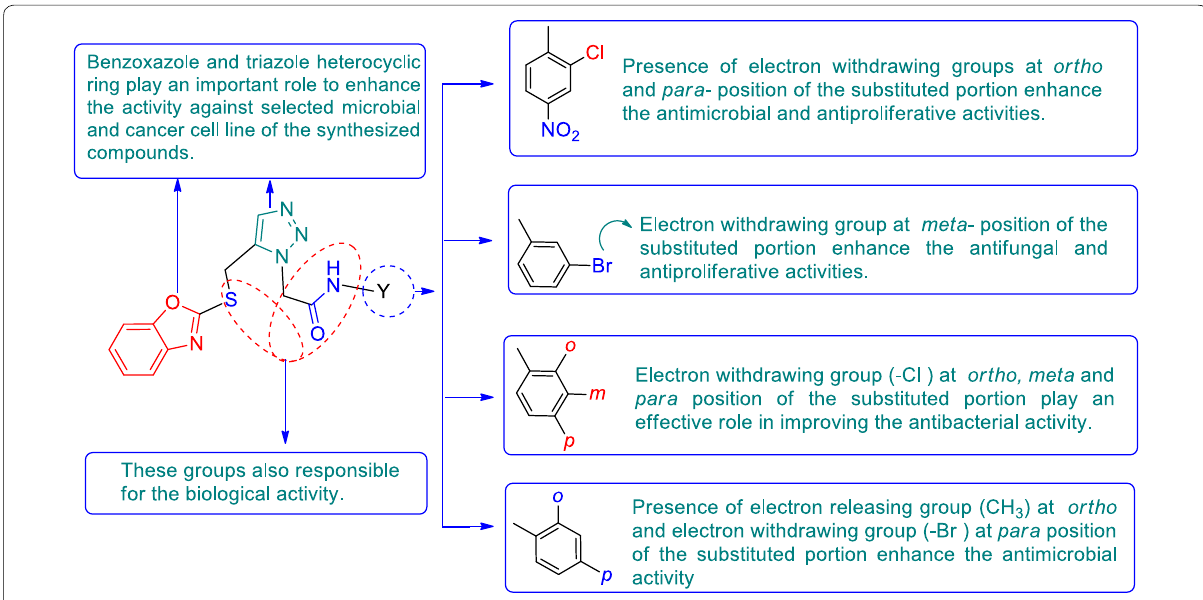
Fig. 4 Structure activity relationship of benzoxazole